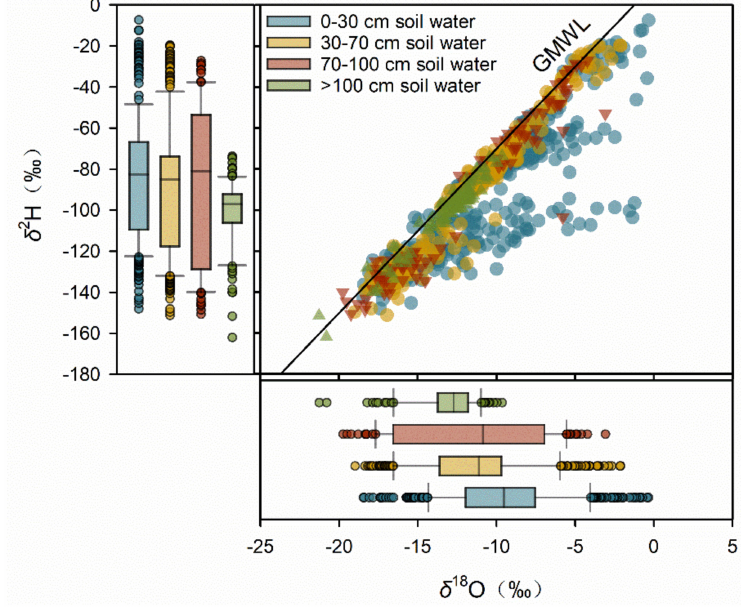
Figure 6. δ 2 H and δ 18 O signatures for soil water at di ff erent depths. Data from